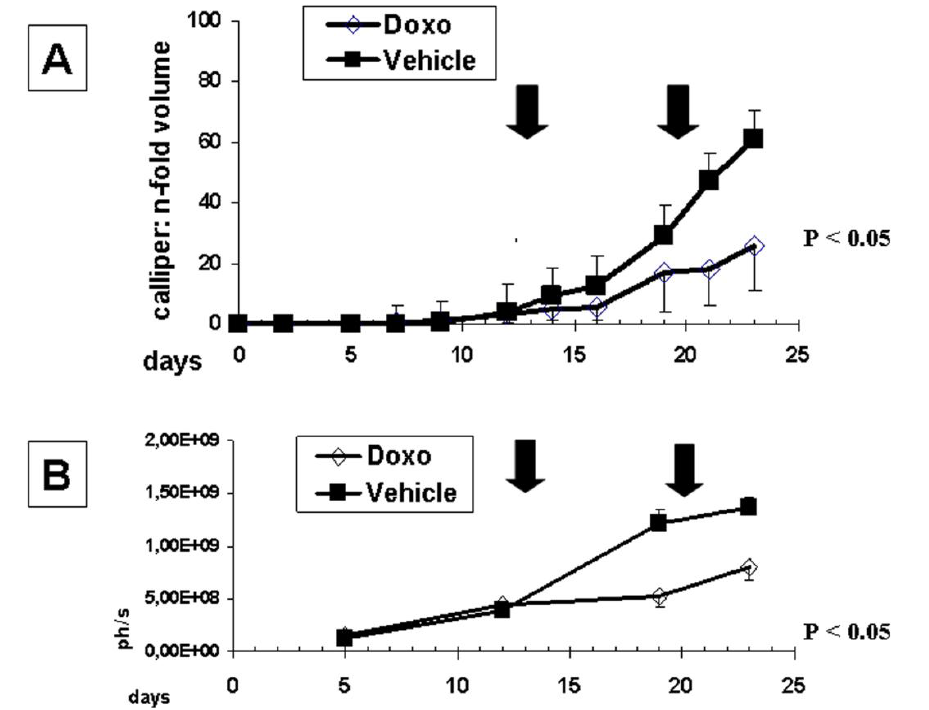
Figure 4. Anti-tumor effects of intravenous bolus doxorubicin application in the subcutaneous MAT-Lu model (1x10 6 cells). Starting with day 13 (palpable tumors: 0.80 ±0.37 × 0.57 ± 0.21) the rats were treated (arrows) two times once weekly with 1 mg/kg doxorubicin or the vehicle (NaCl). At day 23 a significantly (p = 0.0131) reduced subcutaneous tumor growth could be observed compared to the vehicle control (10.3 ± 2.6 cm 3 ). Data refer ( A ) to n-fold tumor volume determined by callipering or ( B ) to bioluminescence (ph/sec) in seven animals (one animal died for other than experimental reasons) in the doxorubicin and eight animals in the control